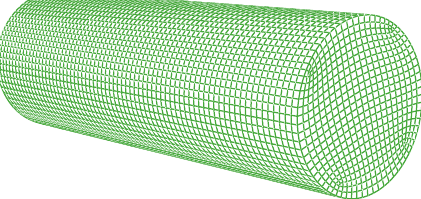
Figure 8: FE mesh used in the simulations of spalling tests with 38,000 8-noded elements.